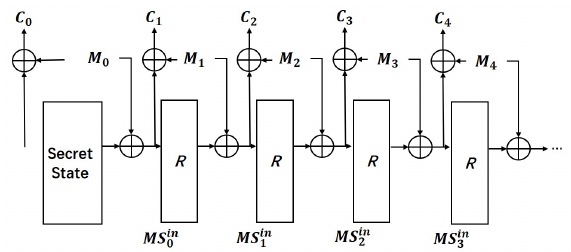
Figure 2: Processing the message